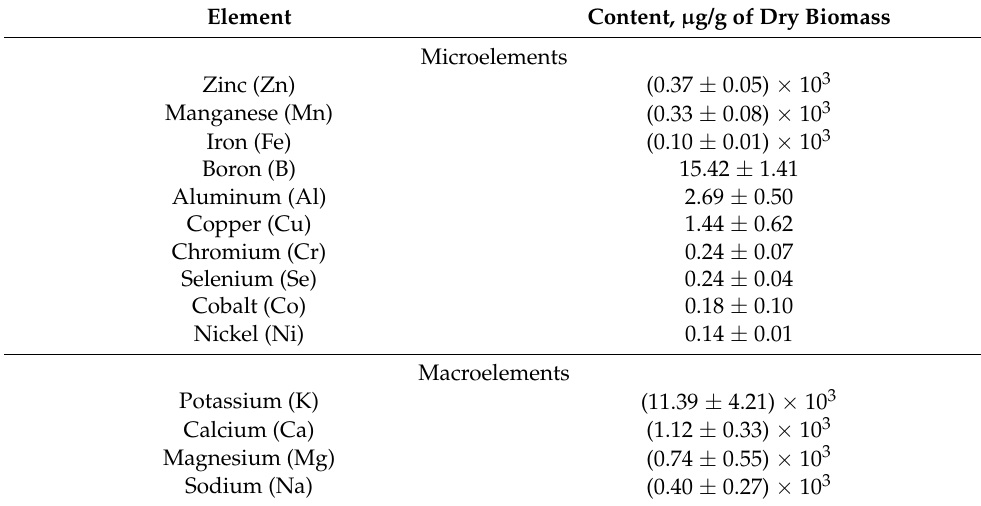
Table 2. Content of macro- and microelements in Dioscorea deltoidea cell biomass.